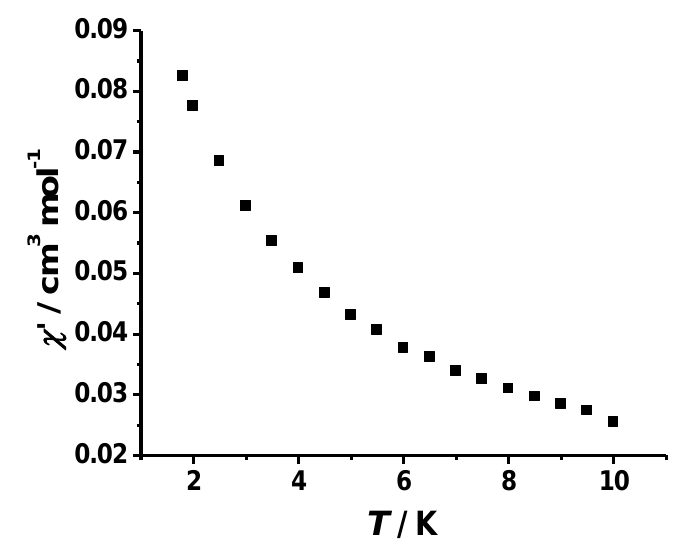
Figure 5. Variable-temperature AC magnetic susceptibilities (in-phase) of complex 1 in an AC field of 5 Oe with a constant frequency of 997 Hz.